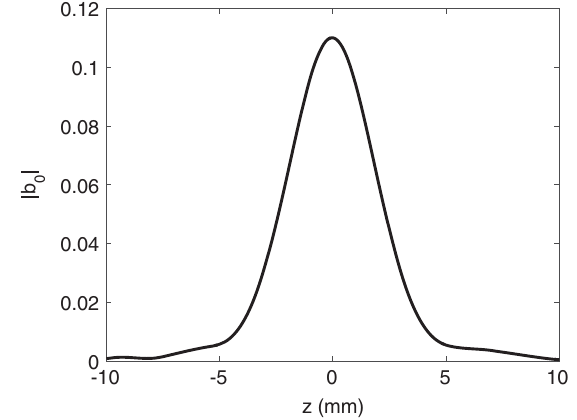
FIG. 9. The bunching factor for the electron bunch modulation at 1.24 nm after the EEX line. The depth of field is 4 mm, approximately ten times the gain length or four times the nominal laser pulse